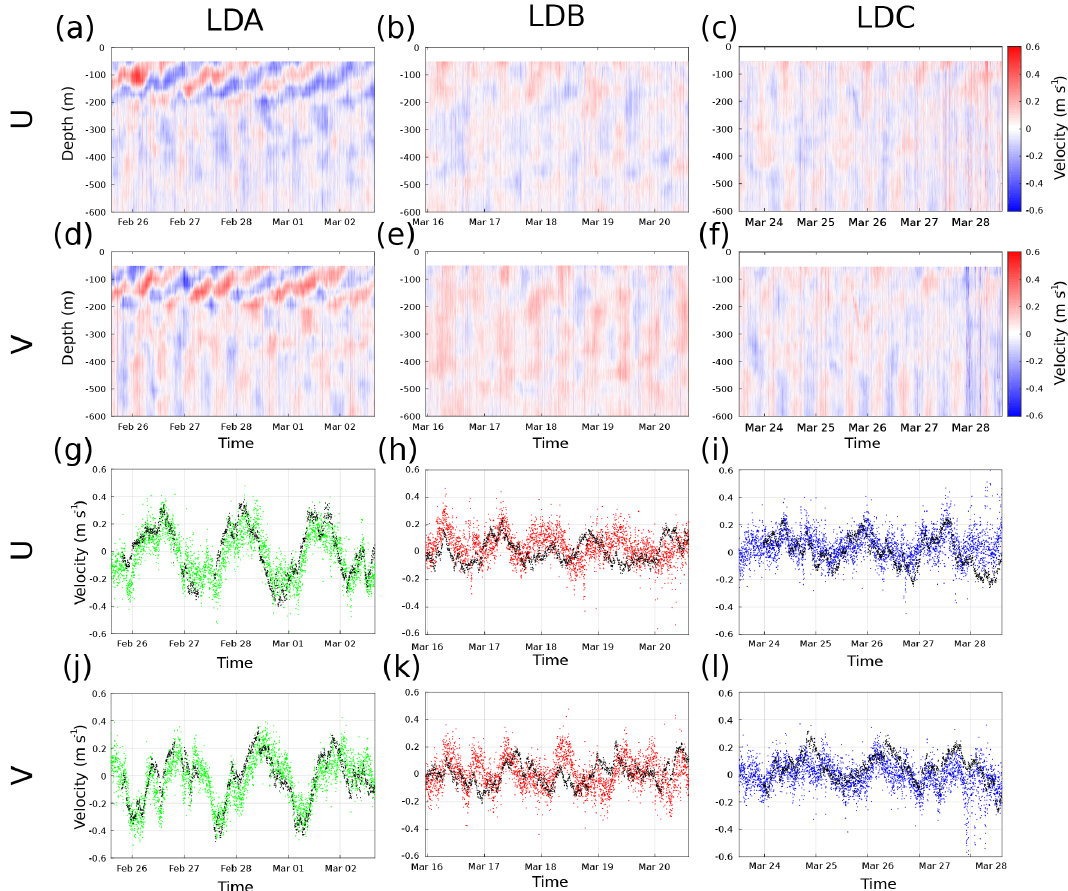
Figure 14. Time series of 38kHz SADCP u and v components over depth for (a, d) LDA, (b, e) LDB, and (c, f) LDC. Comparison of 55m Aquadopp u and v components with 52m SADCP u and v for (g, j) LDA, (h, k) LDB, and (i, l) LDC. Aquadopp measurements shown in black, SADCP measurements follow the color code. Units are in ms − 1